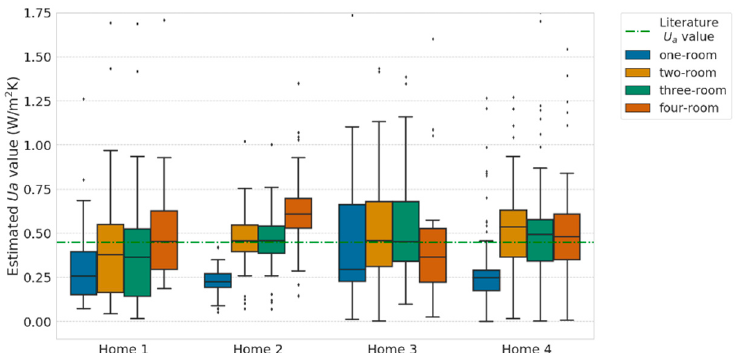
Figure 9. Estimated Ua values for different experimental data (Home 1 to 4) and models (one-, two-, three- and four-room model). The dotted line represents the literature Ua value. Boxplots represent distribution of estimated results for the different models.